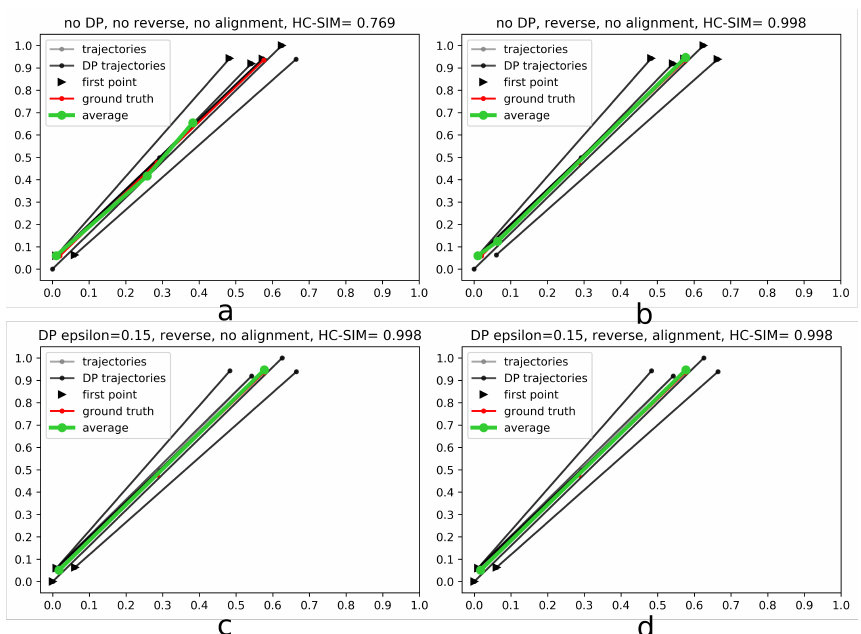
Figure A3. Algorithm applied to sample 49 with and without extensions. ( a ) No extensions just the averaging based on corresponding ids; ( b ) algorithm with reversion. The order of points in trajectory is reversed in order to group all starting points at one side; ( c ) algorithm with DP and (cid:101) set to 0.15; ( d ) algorithm including the alignment of the shorter paths.